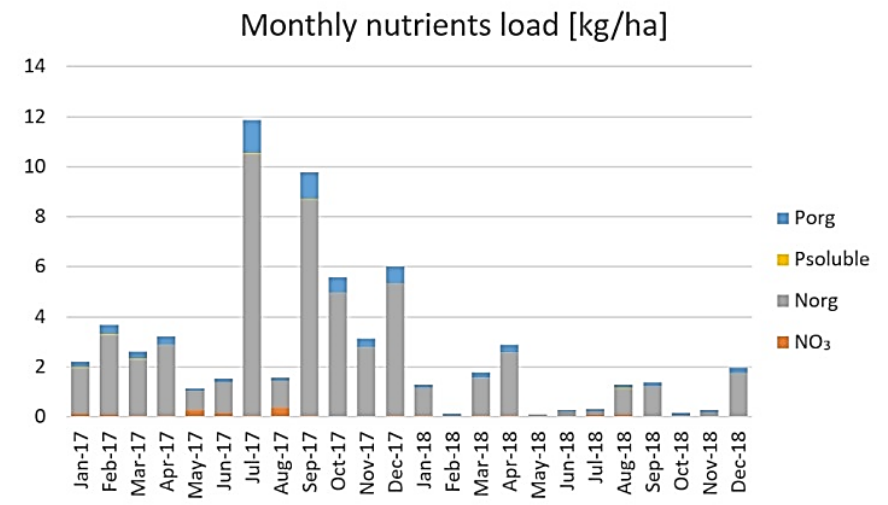
Figure 4. Monthly nutrients load into the stream for Polish Canola.